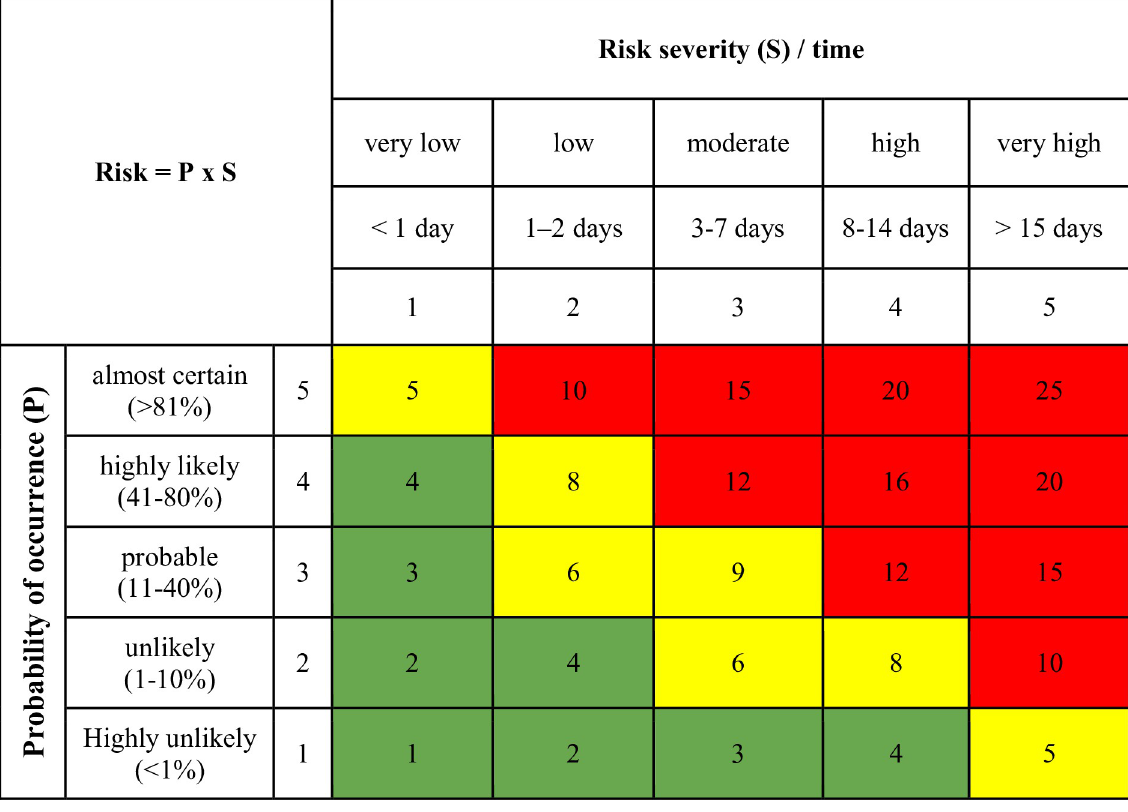
Fig 2. Risk classification matrix (source: Internal